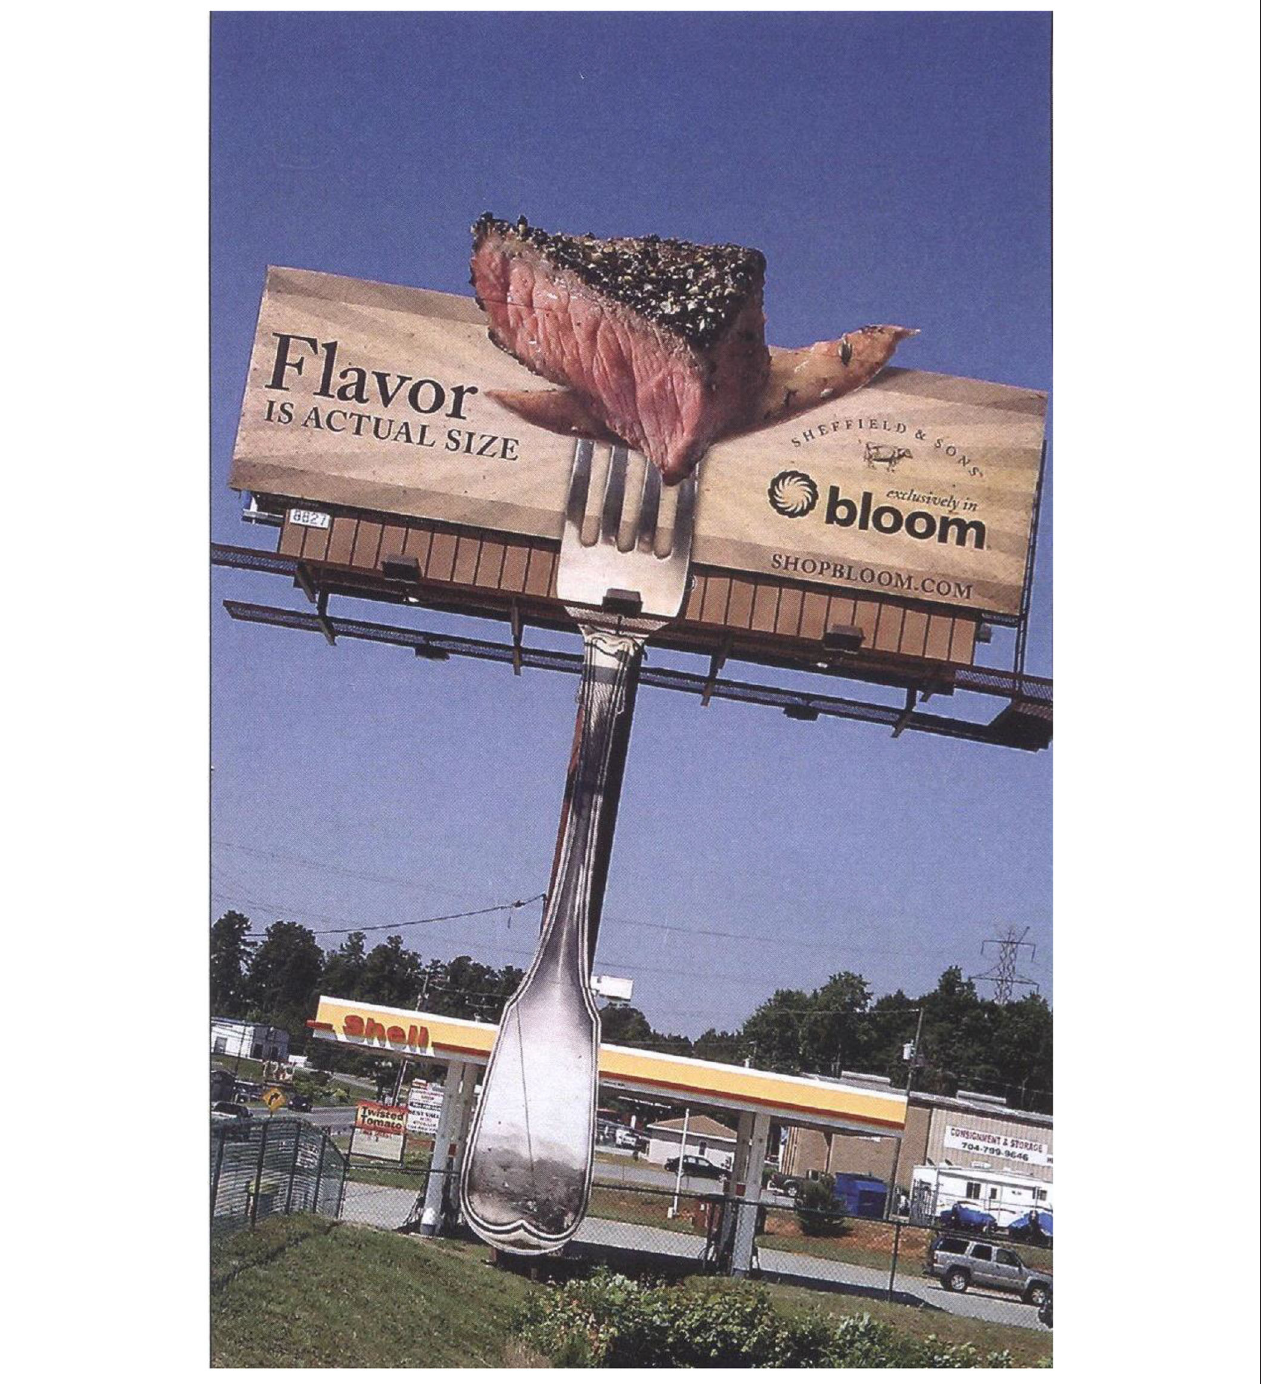
FIGURE 2 | Scented advertisement on Highway 150, North Carolina, USA. In this case, while the commuter is moving, the scent is